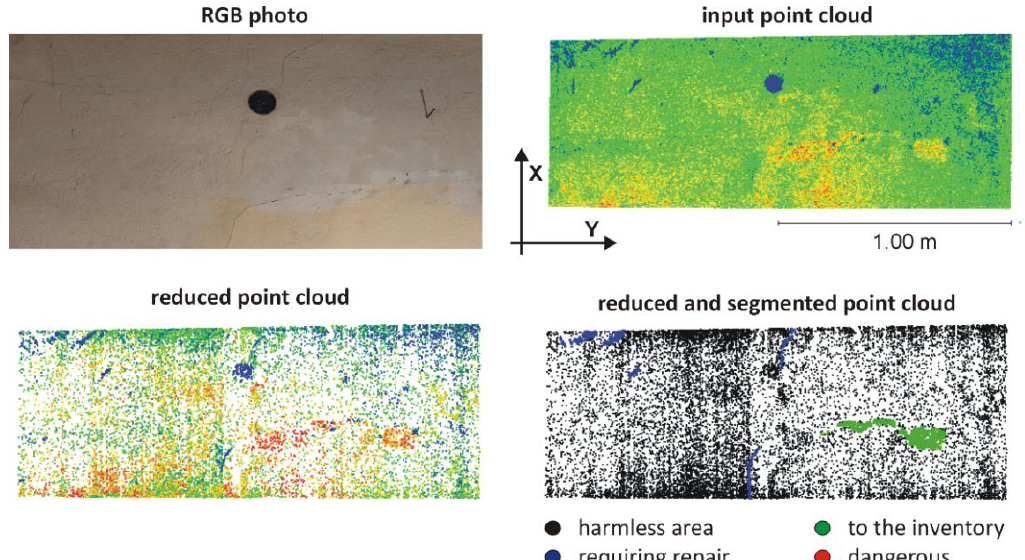
Figure 5. Detection of basement wall defects based on OptD segmentation in OXYI coordinate system – object1 fragment